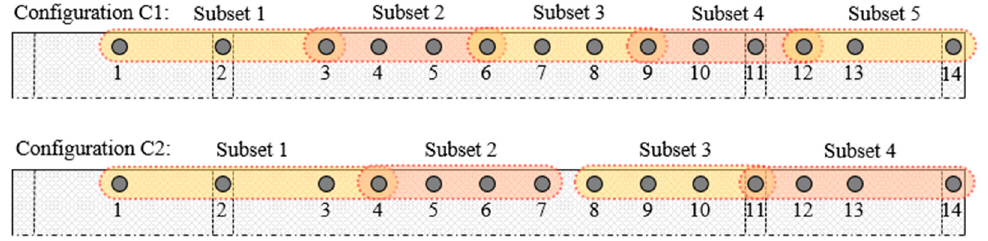
Figure 9. S101 bridge: Sensor subset configurations.